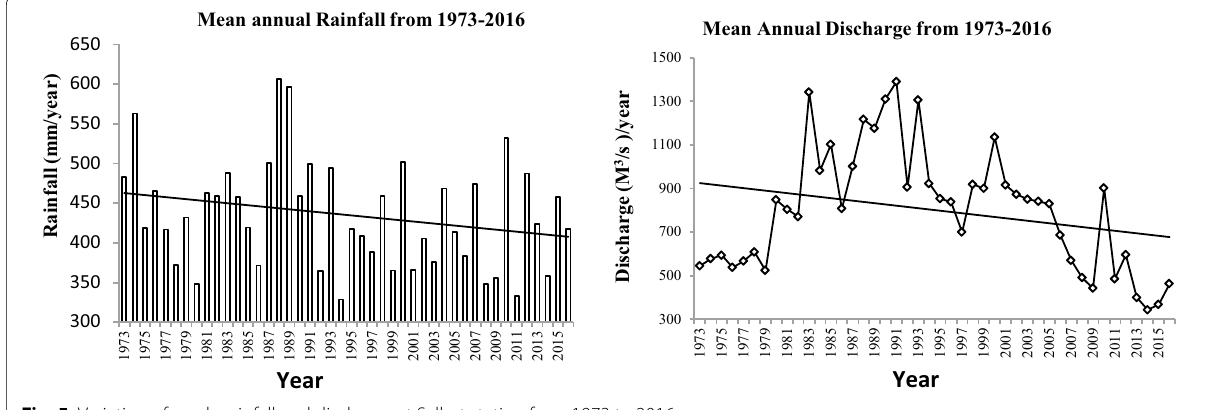
Fig. 5 Variation of yearly rainfall and discharge at Sylhet station from 1973 to 2016